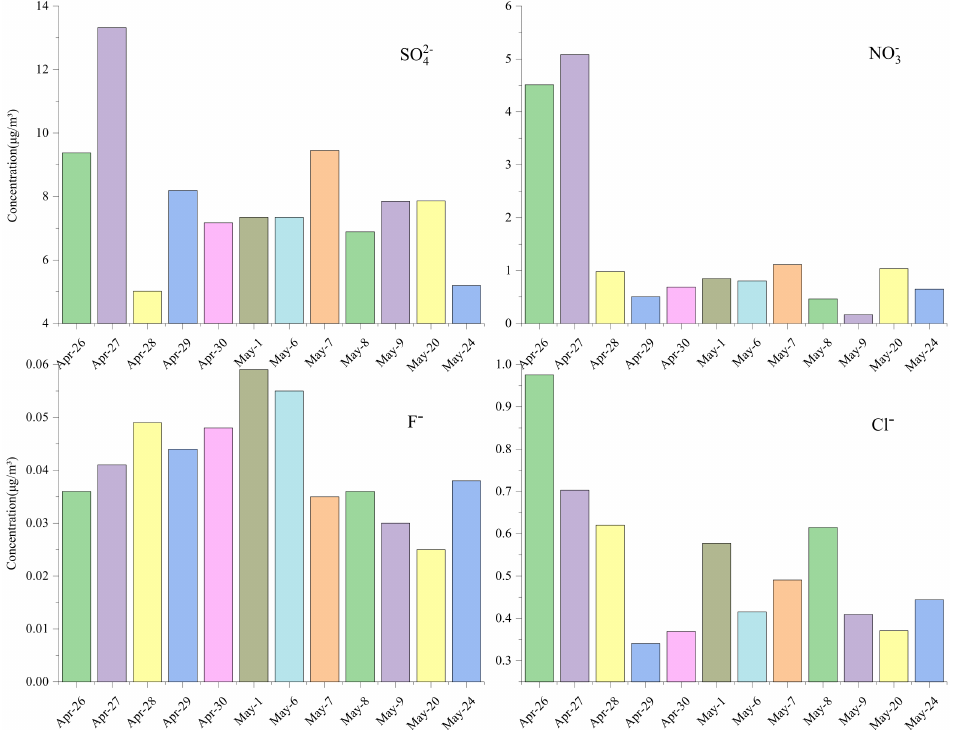
Figure 4. Concentration data of four ions during